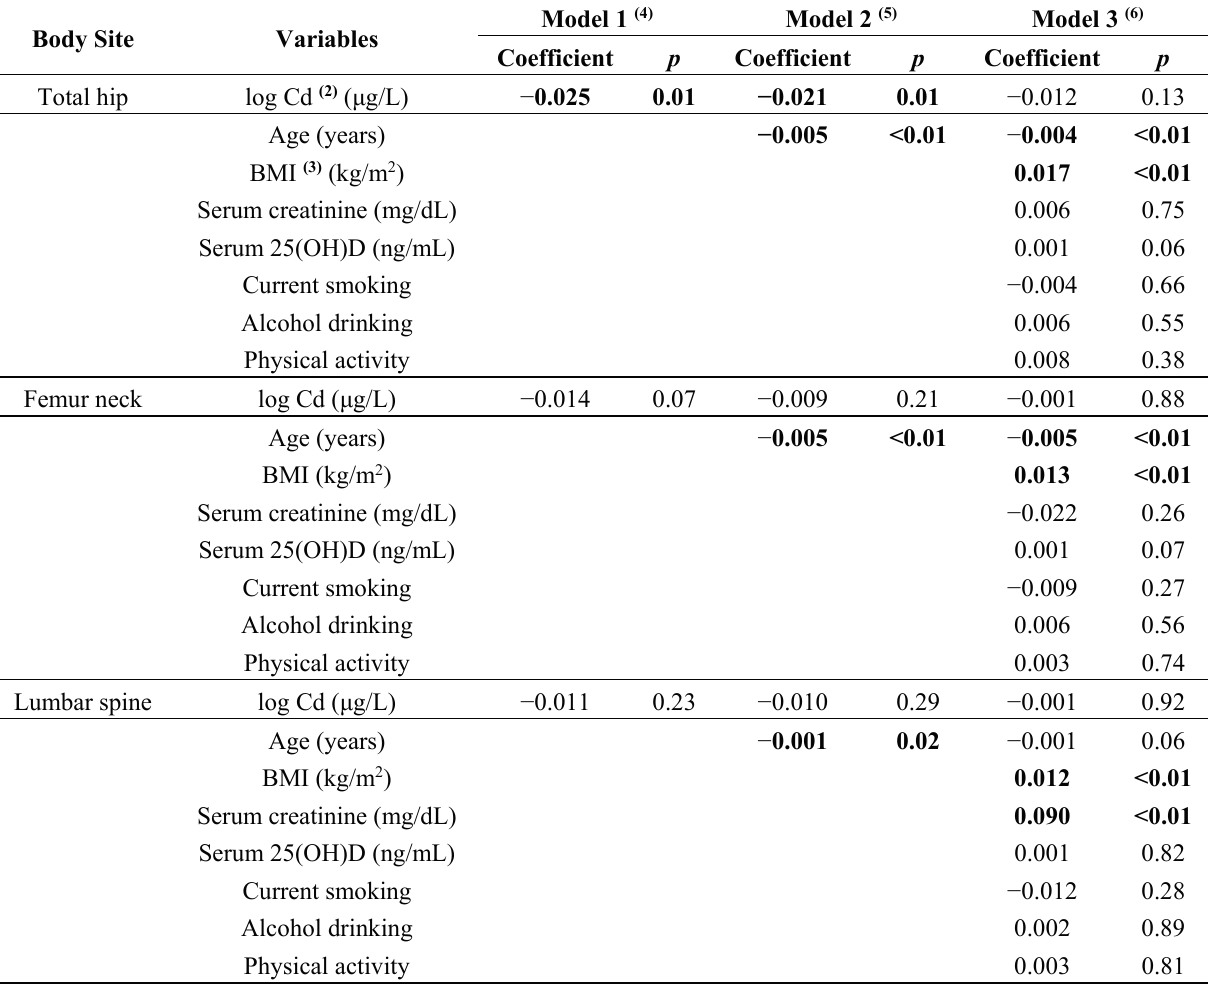
Table 3. Effects of blood cadmium on bone mineral density (1) (results of regression